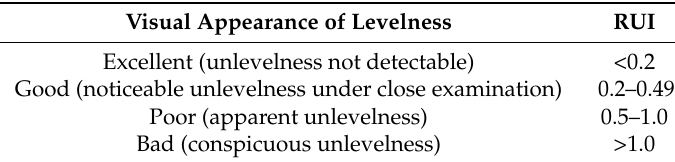
Table 4. Relative unlevelness index (RUI) interpretation